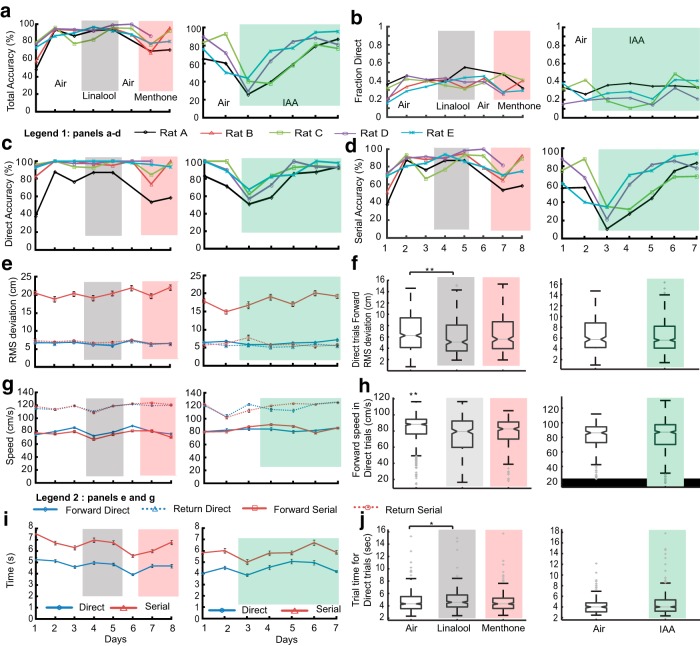
Background odor identity transiently affects accuracy of odor localization. Foreground tracking odor is Limonene (0.5%). Control (air background) is represented in white. Rats take 1-2 days to stabilize to the reduced tracking odor concentrations. Linalool background is gray shaded, Menthone is red shaded and IAA is green shaded. a, Total accuracy of all rats with background odors. There is a small drop for menthone, and a large drop for IAA. b, Fraction of direct trials for all rats. c, Accuracy of direct (d) and serial trials for all rats with different background odors. There is a particularly large dip for IAA. e, Average RMS deviation of all rats for direct and serial trials in forward and return direction. f, Averaged RMS deviation in direct trials during forward tracking. Data pooled for all rats and trials. RMS deviation with air (Nd = 524) was significantly different from days with Linalool (Nd = 295), but not from days with menthone (Nd = 241) as background (**p < 10−3, KW Tukey HSD test). RMS deviations for days with IAA (Nd = 540) did not differ from air (Nd = 211, KW Tukey HSD test). g, Mean forward and return speeds for direct and serial trials for different background odors. h, Averaged speeds for all direct trials during forward tracking with Linalool, Menthone and IAA as background odors. Speeds for both Linalool and Menthone were significantly lower than baseline (**p <10−8, KW Tukey HSD test). Speed for IAA (all days pooled) and air as background were not significantly different. i, Total trial time taken for different background odors in direct and serial trials. j, Average trial time for direct trials pooled across all days for air/Linalool/menthone and air/IAA as background. Air background trial time is lower than Linalool (*p = 0.03, KW Tukey HSD test). Menthone as background did not affect trial time. Average trial time pooled for days with IAA as background was not significantly different from with background air (5% significance, KW Tukey HSD test). Error bars on all panels represent SEM values.